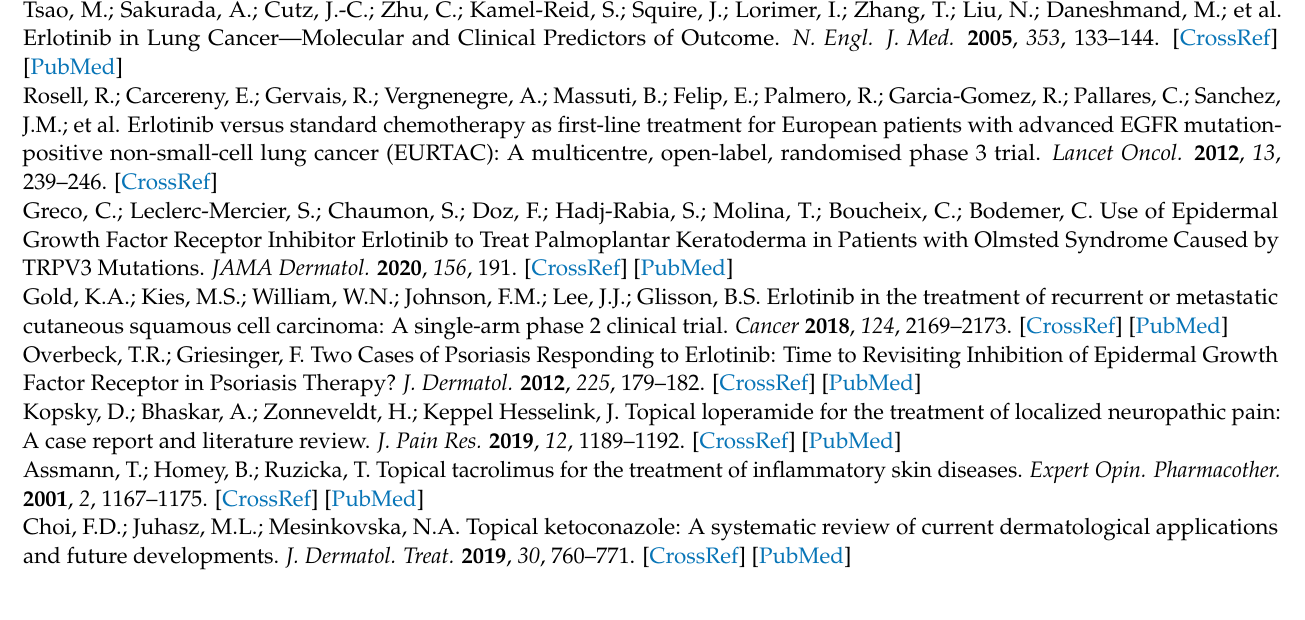
Supplementary Materials: The Supplementary Materials are available online. Figure S1: HPLC chromatograms of ERL in acidic conditions, Figure S2: HPLC chromatograms of ERL in alkaline conditions, Figure S3: HPLC chromatograms of ERL in oxidative conditions, Figure S4: HPLC chromatograms of ERL in photolytic